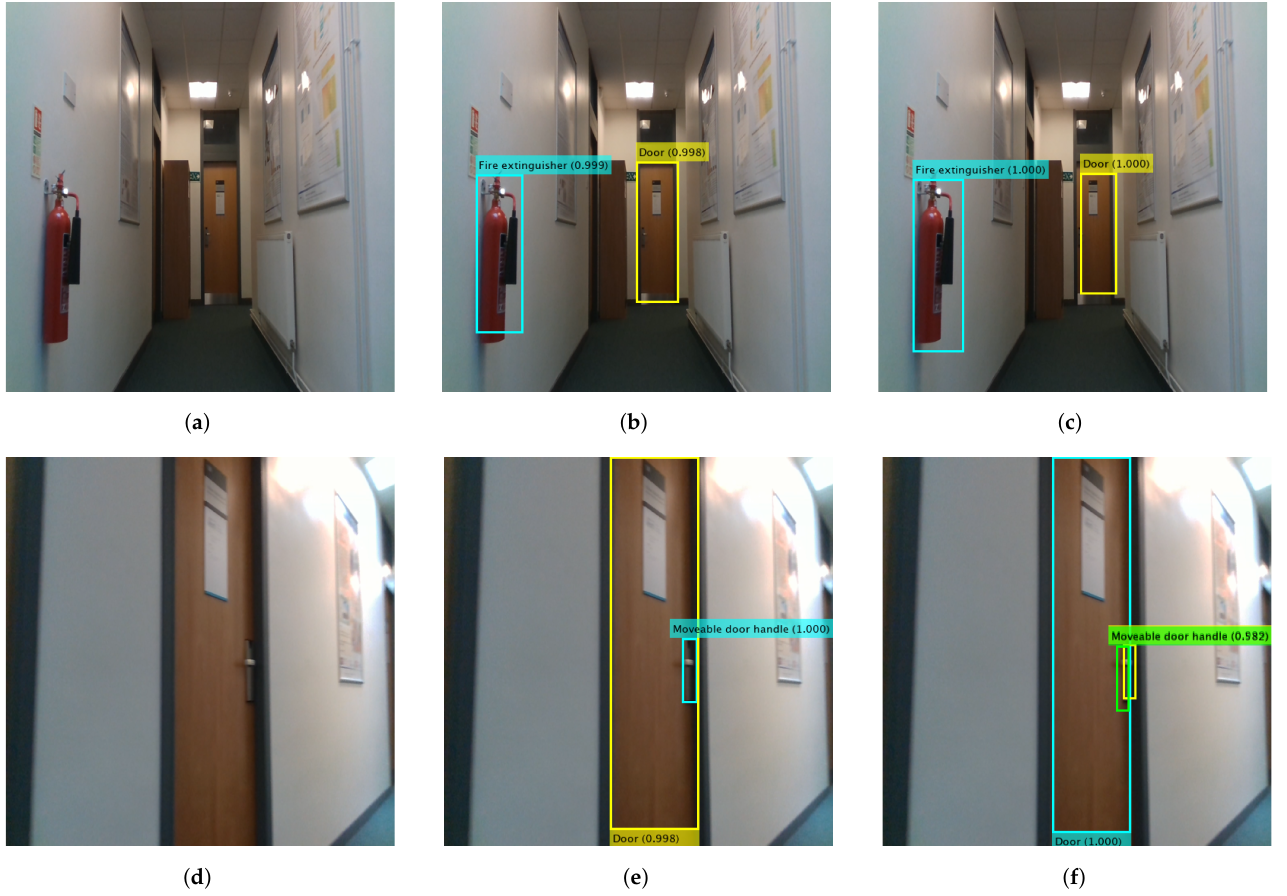
Figure 3. Prediction results of single head YOLO V3 and Faster R-CNN detectors on two test images. ( a , d ) Test images. ( b , e ) Output of YOLO V3. ( c , f ) Output of Faster